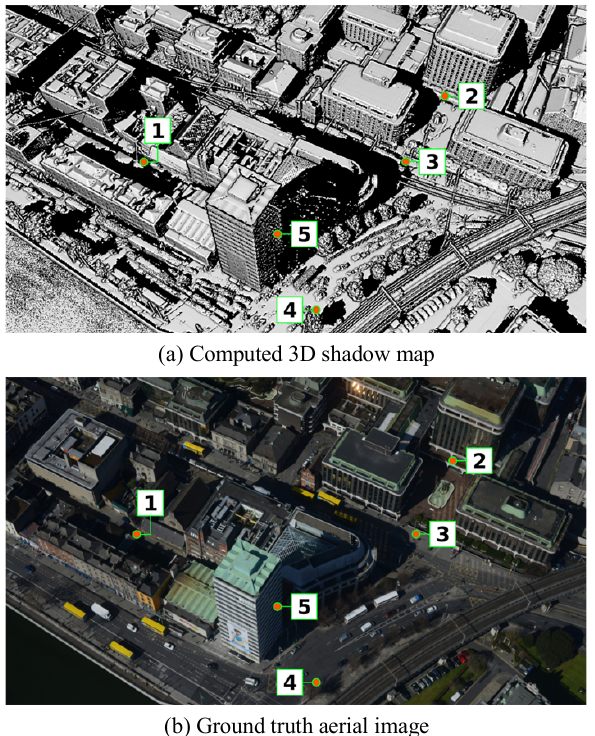
Figure 3. 3D shadow point cloud of the Liberty Hall and the surrounding computed for 12:50:47 26/03/2015